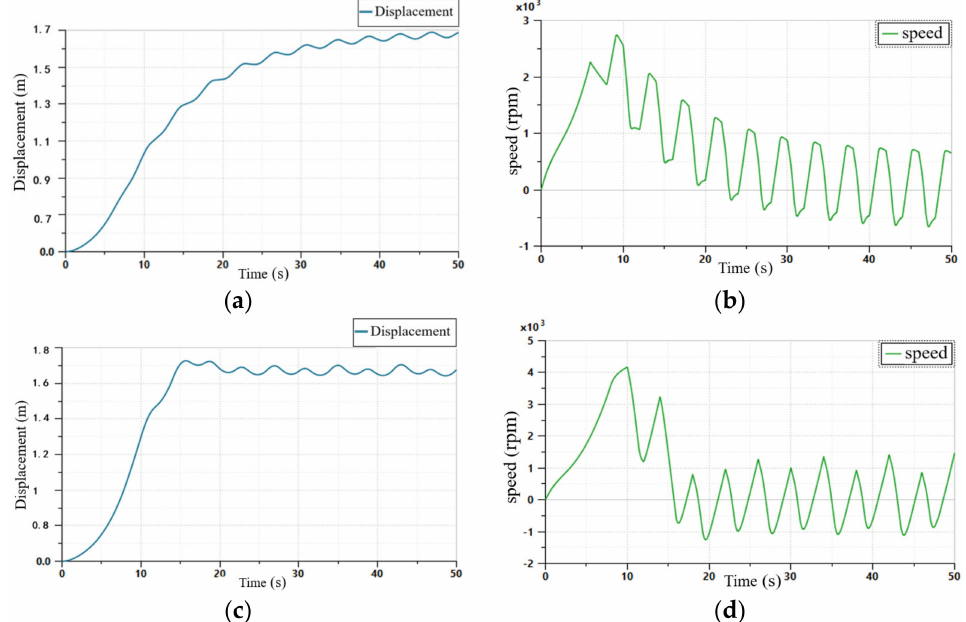
Figure 14. Simulation results of the control algorithm under the influence of periodic lateral force: ( a ) erecting displacement of PID; ( b ) motor speed of PID; ( c ) erecting displacement of ARDC; ( d ) motor speed of ADRC.